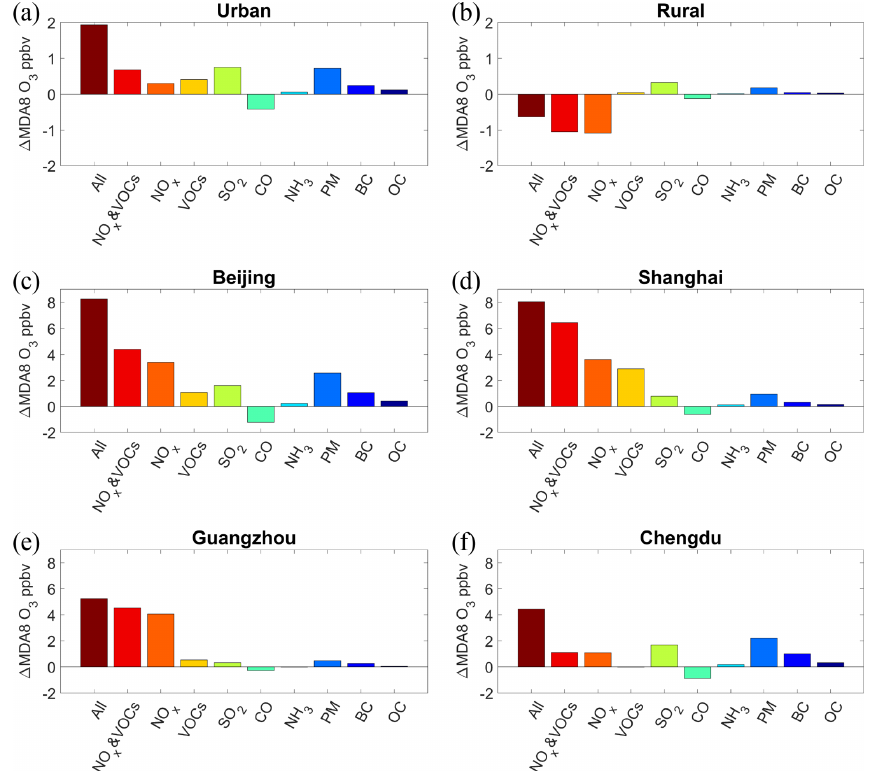
Figure 4. Response of the simulated MDA8 O 3 mixing ratios to the changes in individual pollutant emissions in summer from 2013 to 2017 in (a) the urban areas, (b) the rural areas, (c) Beijing, (d) Shanghai, (e) Guangzhou, and (f) Chengdu. See Fig. S1 in Part 1 (Liu and Wang, 2020) for the locations of the four